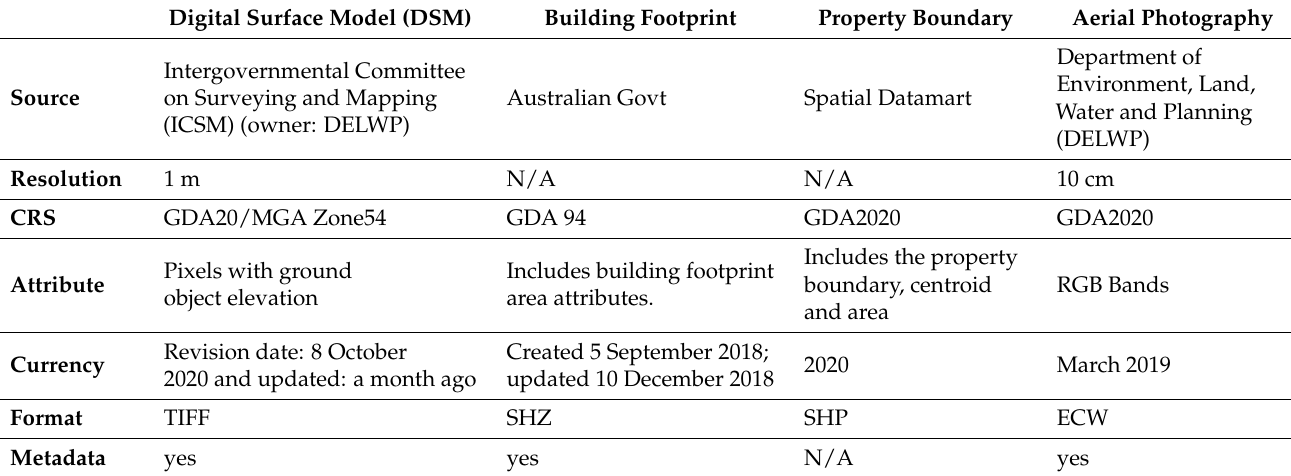
Figure 1. Study area: Ballarat city, Victoria, Australia. Table 2. Summary of datasets used in the research